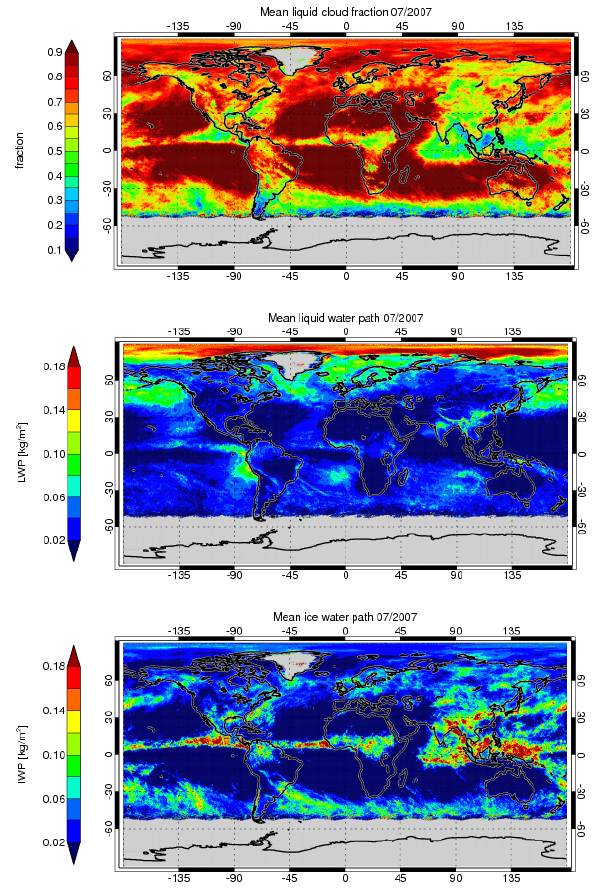
Figure 4. Fraction of liquid clouds relative to total cloud fraction (top panel), all-sky liquid water path (middle panel) and all-sky ice water path (bottom panel) for the month of July 2007. Regions without values are grey-shaded. This concerns locations for which no re- trievals were performed because of too high surface albedo (Green- land) or solar zenith angle (Southern Hemisphere high latitudes).